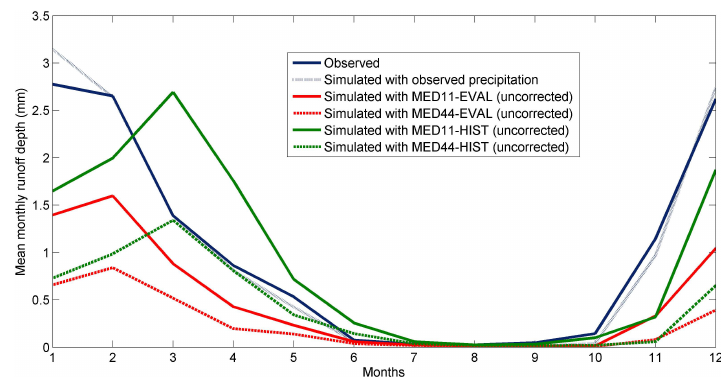
Fig. 10. Mean monthly runoff simulated with observed and RCM precipitation